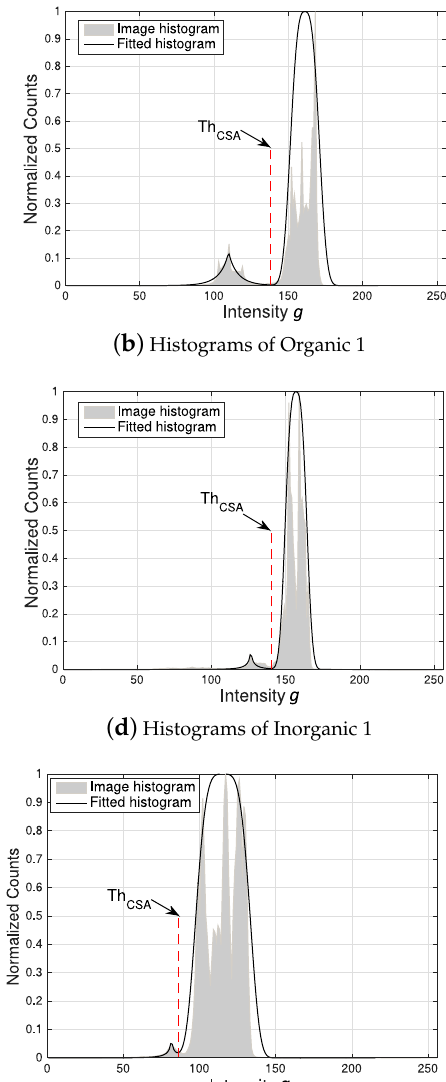
Figure 6b, the algorithm ThCSA computed a good threshold to segment the organic object, which is bounded with a white line in Figure 6a.